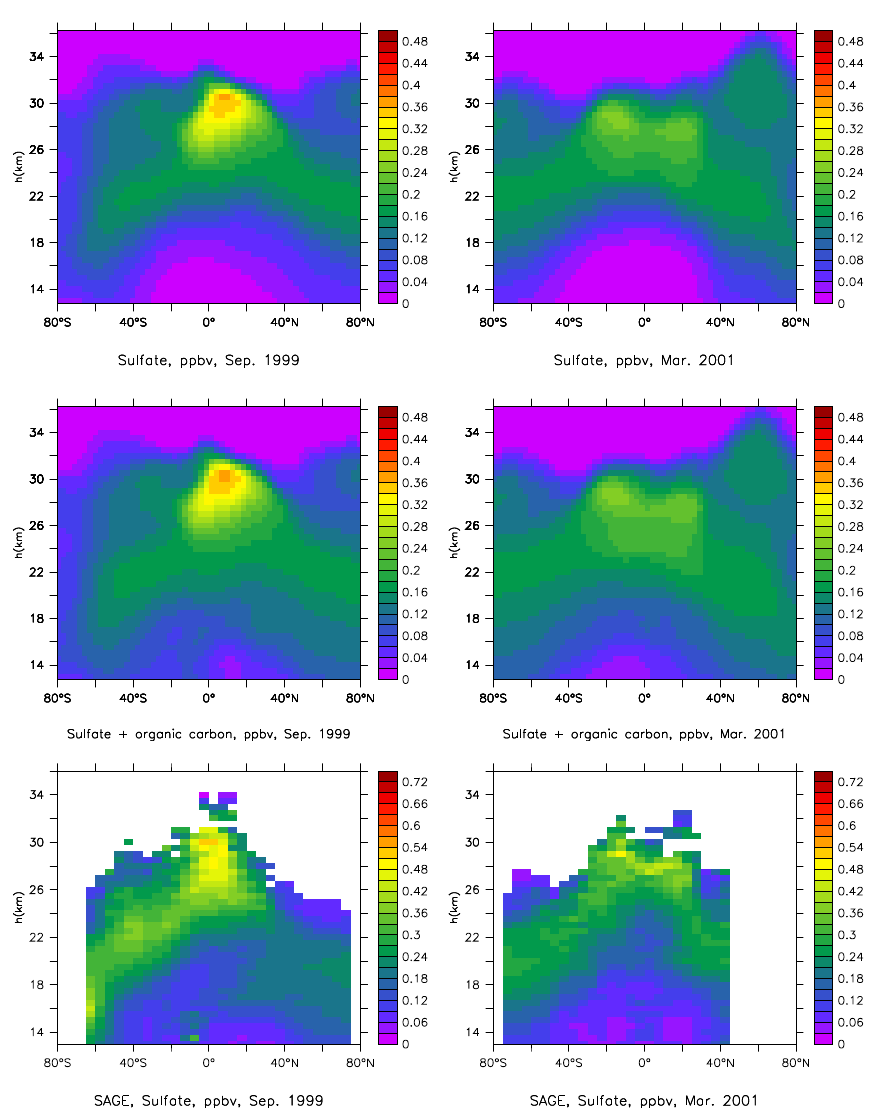
Fig. 4. Simulated (upper panels) and observed (lower panels, derived from SAGE) sulphate aerosol in September 1999 (left) and March 2001 (right), ppbv. The middle panels includes simulated organic carbon aerosol (mostly from biomass burning, mass weighted). Note that the color scale of the model covers only 67% of the range of the one for the observations to account for the model’s low bias and to allow for more convenient comparisons of